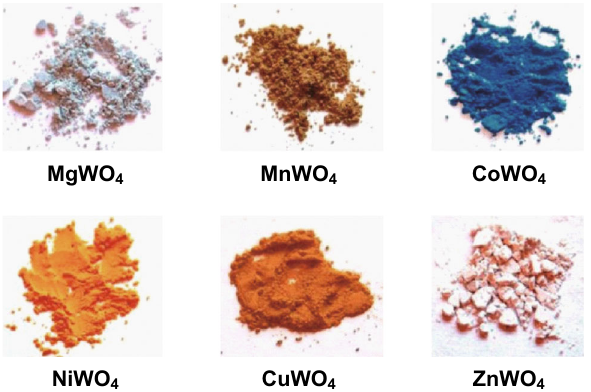
Fig. 3 Colors of different MWO 4 materials. Reproduced with permission from Ref. [51]. Copyright 2014 American Chemical